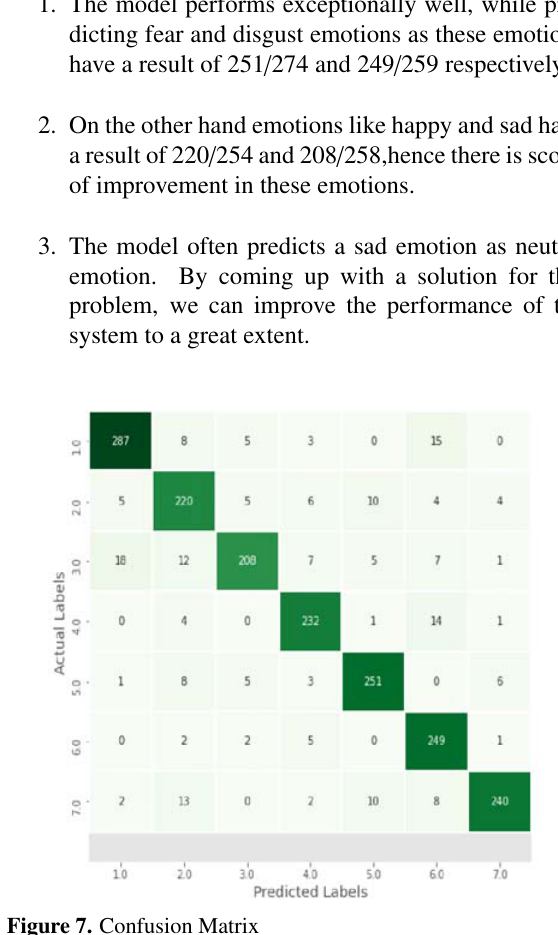
Figure 5. Loss Curves